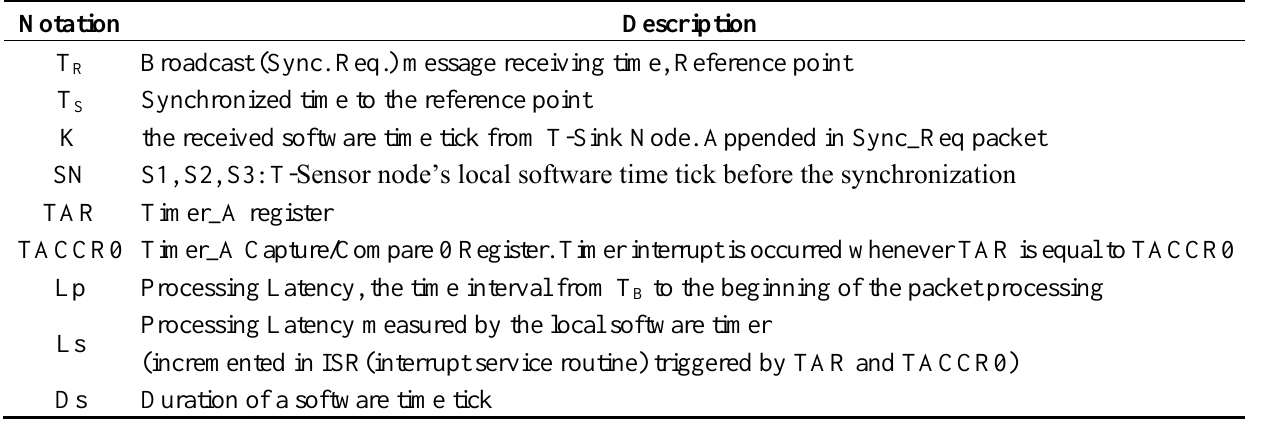
Table 3. Notation used in Figures 4 and 5 for the T-Sensor node time